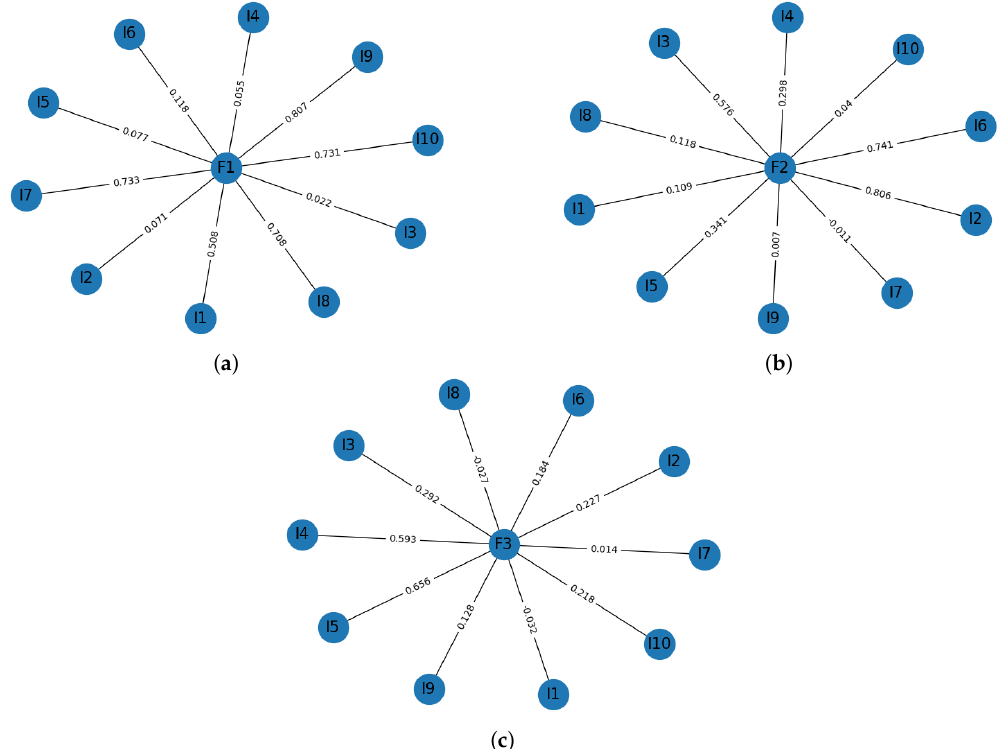
Figure 3. Factorial model for the BSSA-10 instrument. ( a ) BSSA-10 SP. ( b ) BSSA-10 AE. ( c ) BSSA-10